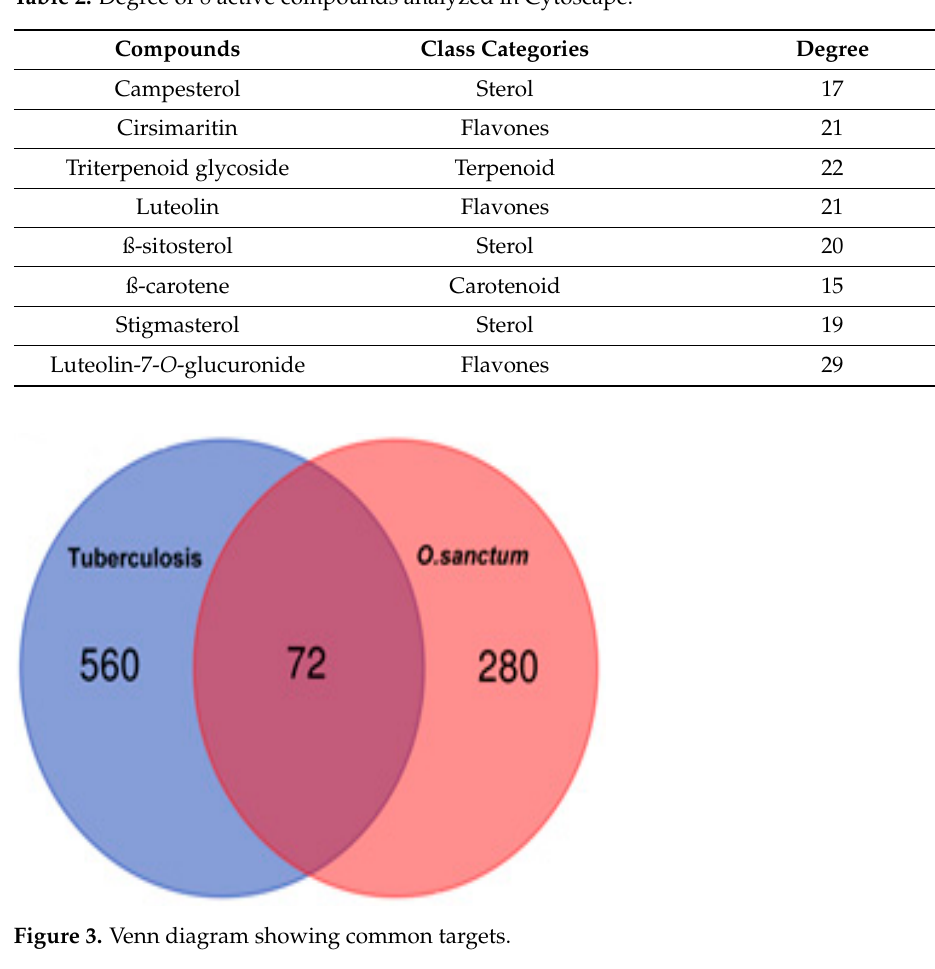
Table 2. Degree of 8 active compounds analyzed in Cytoscape.